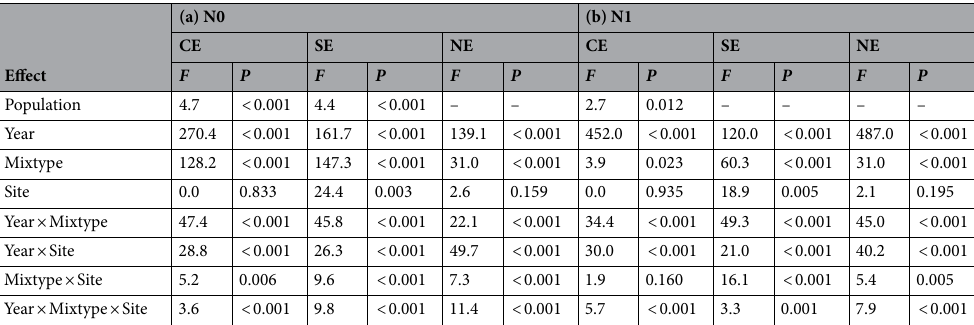
Table 1. Effect of white clover population, experimental year, mixture type and study site on complementarity effect (CE), selection effect (SE) and net biodiversity effect (NE) using ( a ) unfertilized (N0) and ( b ) fertilized (N1) non-leguminous reference stands. F - and P -values of sequential Wald chi-square tests are given. – Effect not retained in the minimum adequate model.